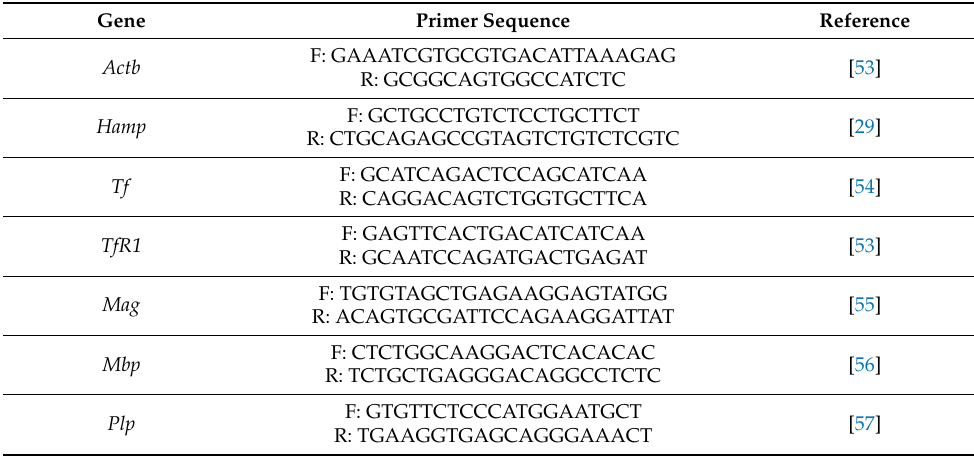
Table 2. Real-time PCR primer